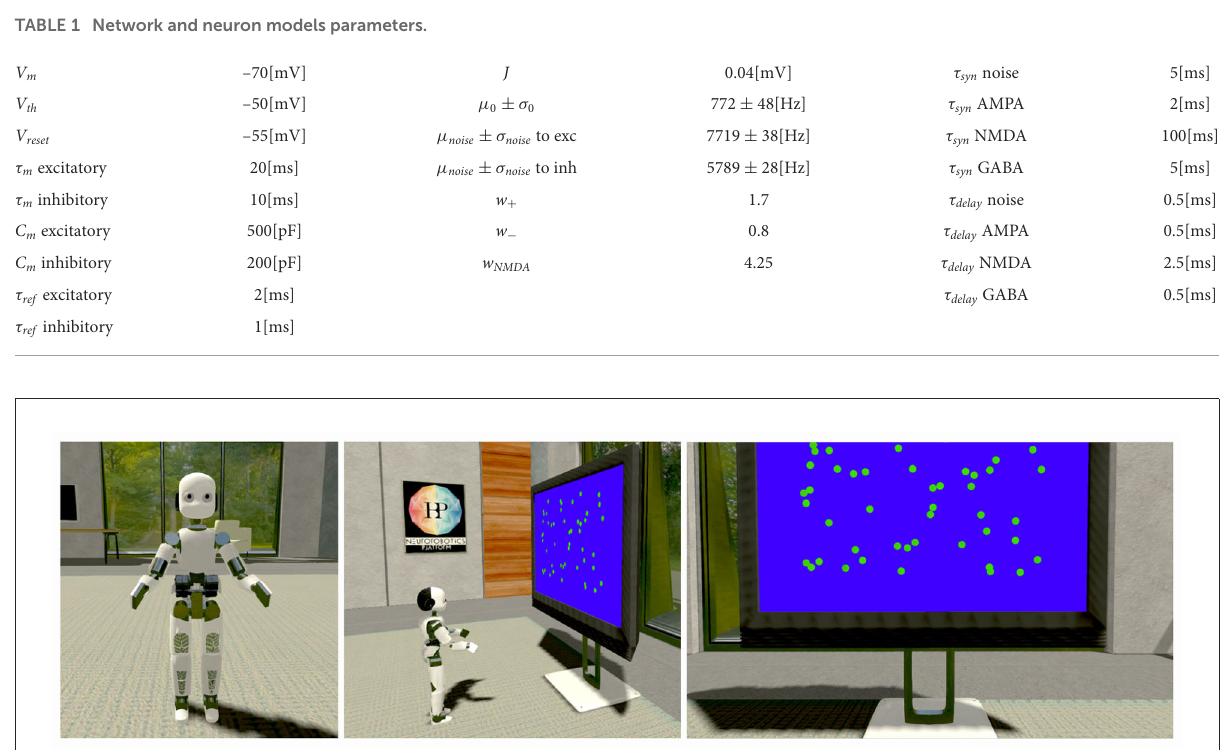
FIGURE2 Neurorobotics platforms (NRP) experimental setting: In the proposed NRP implementation of a visual discrimination task, an iCub humanoid robot ( left ) is placed in front of a screen displaying fifty random moving green dots ( center ), occupying most of the robot’s field of view ( right ). During each trial, the robotic subject is required to fixate the screen and report the perceived coherent motion of the point cloud with a saccadic eye movement, as in the corresponding primate experiments reported in the literature (Britten et al., 1996; Shadlen and Newsome, 2001; Roitman and Shadlen,